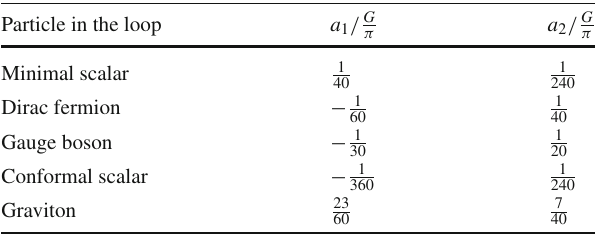
Table 1 Different particles contribution to the graviton self-energy at the one-loop level, a 1 and a 2 are coefficients in the graviton form factor Π μνρσ as shown in Eq.